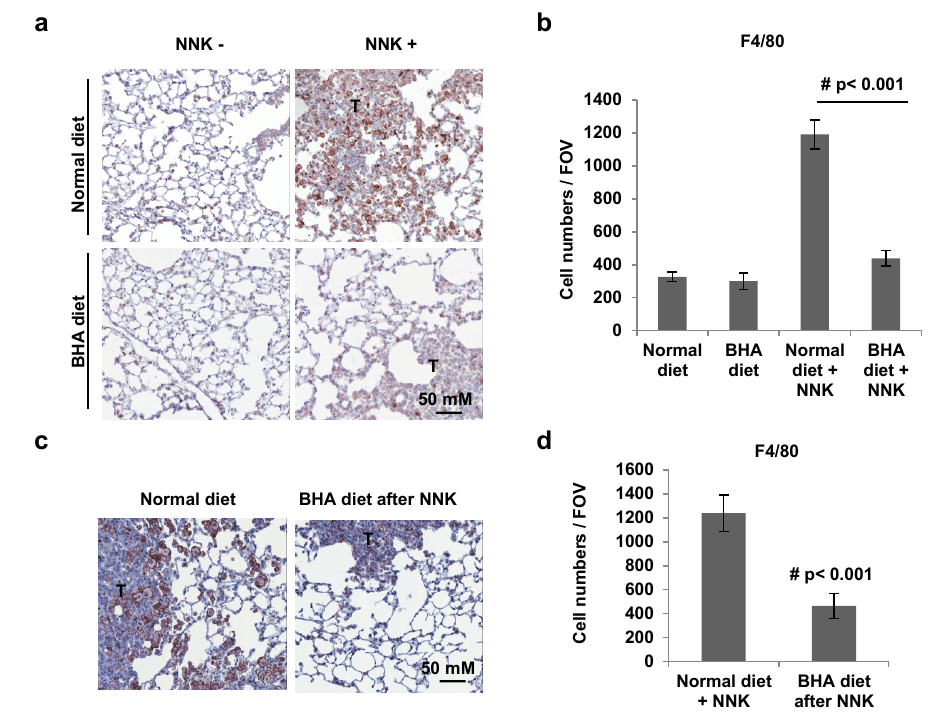
Figure 3. BHA blocks NNK-induced occurrence of F4/80 + macrophages in lungs. ( a ) A/J mice were maintained on normal or BHA diet for 2 weeks prior to NNK injection. Lungs were collected at 6 months after NNK treatment and sectioned and immunostained for F4/80. Representative images are shown (T: tumor area); ( b ) Quantitative analysis of ( a ) is shown. The F4/80 + cells were evaluated by counting 10 high power fields (20×) per lung section (1 mm)/2 tissue sections/ mouse. n = 10 mice; ( c ) A/J mice were maintained on normal or BHA diet 1 week after NNK treatment. Lungs were collected at 6 months after NNK treatment and sectioned and immunostained for F4/80. Representative images are shown (T: tumor area); ( d ) Quantitative analysis of ( c ) is